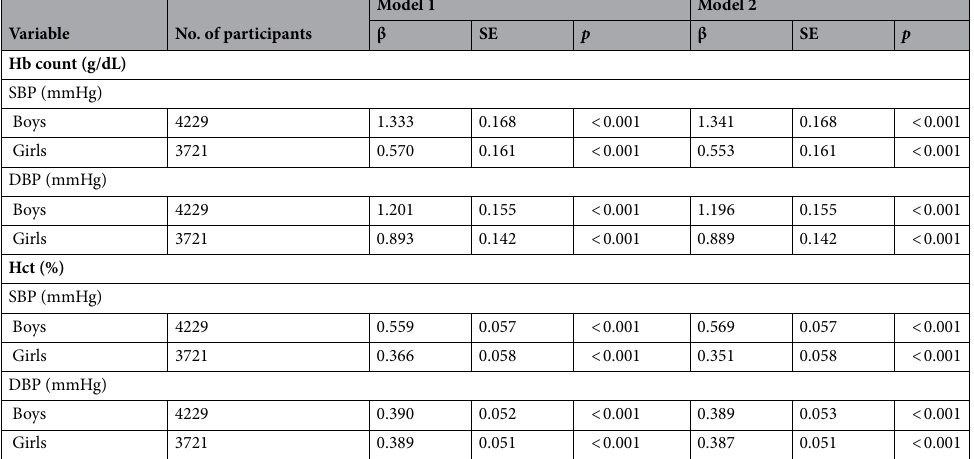
Table 4. Multiple linear regression of hemoglobin count and hematocrit against blood pressure in children and adolescents 10–18 years old ( n = 7950). Hb hemoglobin; Hct hematocrit; SBP systolic blood pressure; DBP diastolic blood pressure; BMI body mass index; SDS standard deviation score; T2DM type 2 diabetes mellitus. Model 1: Statistical significance was determined using multiple linear regression of Hb count and Hct versus blood pressure after adjusting for age and BMI SDS. Model 2: Statistical significance was determined using multiple linear regression of Hb count and Hct versus blood pressure after adjusting for age, BMI SDS, alcohol consumption, smoking status, physical activity, rural residence, household income, diagnosis of T2DM, hypertension, and